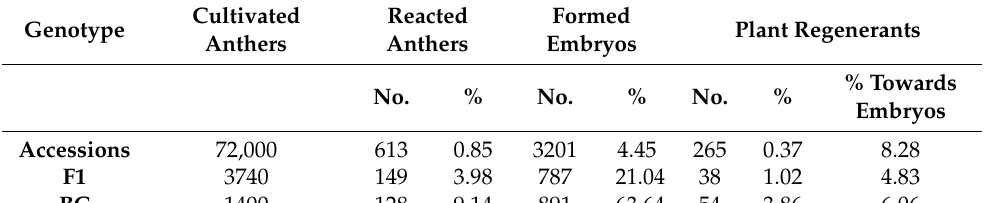
Table 1. Summarized results of androgenic response in 180 accessions, 4 F1, and 7 BC pepper